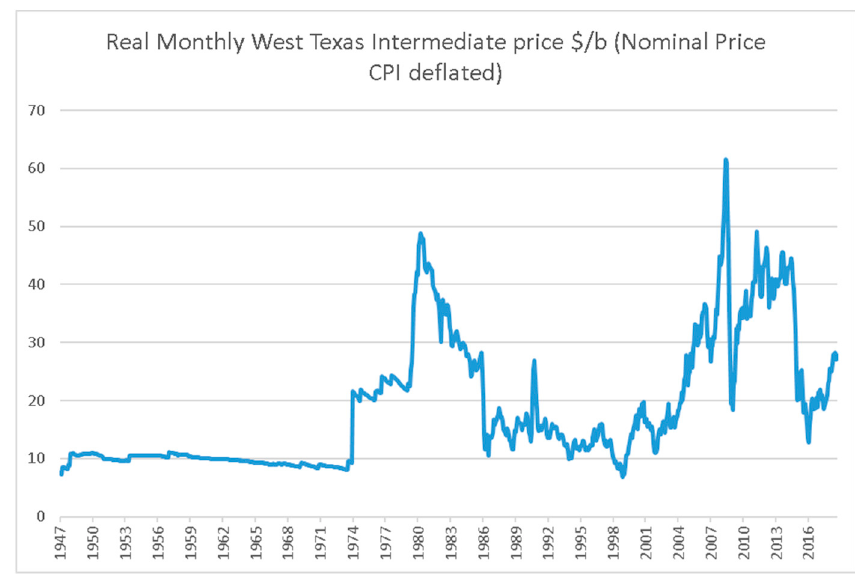
Figure 1. Real Monthly West Texas Intermediate (WTI) Price—Nominal WTI CPI (Consumer Price